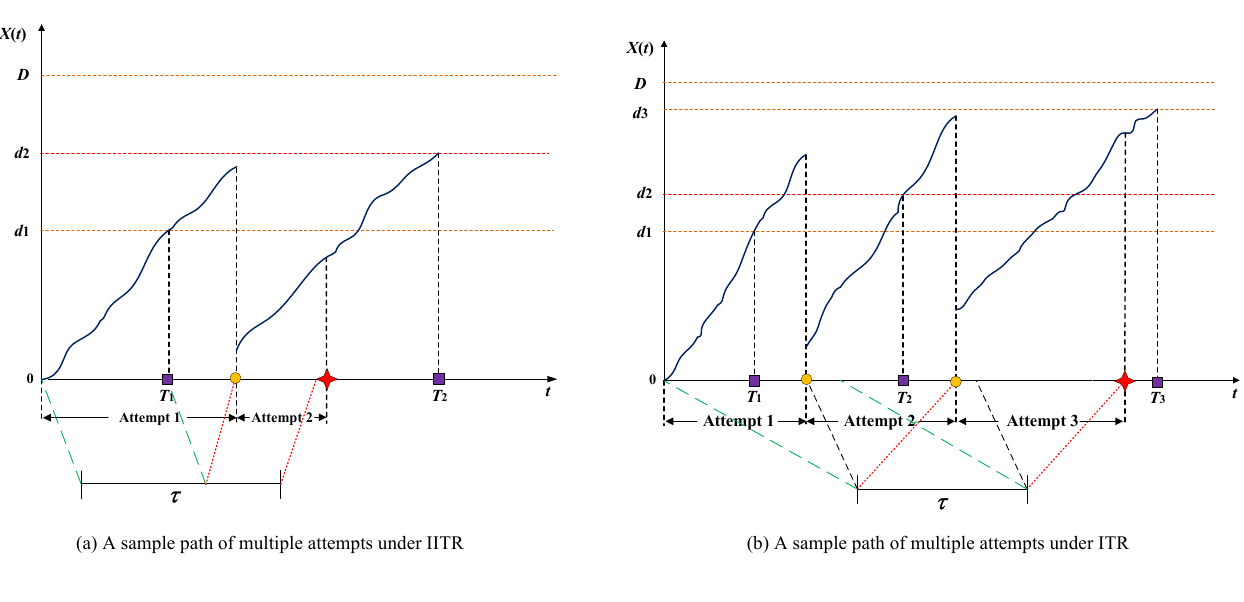
Figure 1. A sample path of multiple attempts under type I time